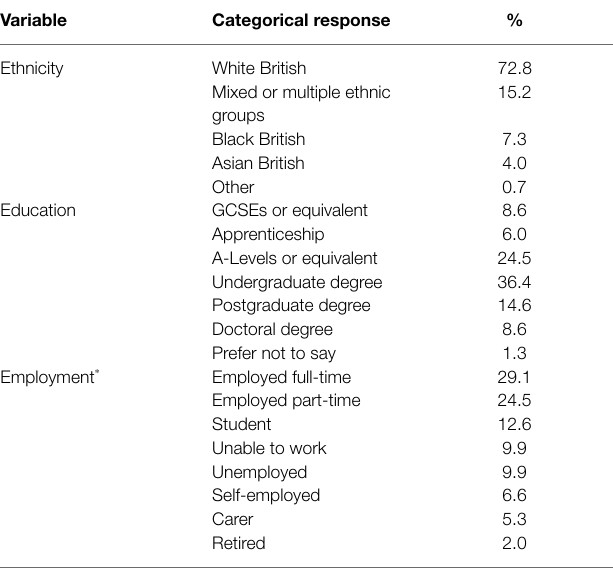
* Denotes that participants could select multiple